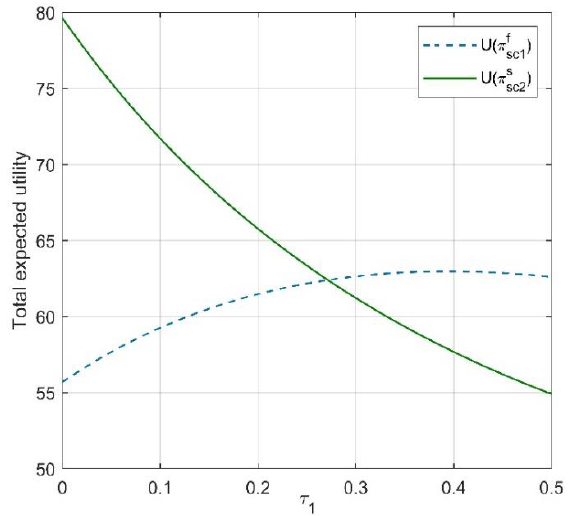
Figure 4. Changes in total expected utility of the two supply chains with τ 1 in the second case.